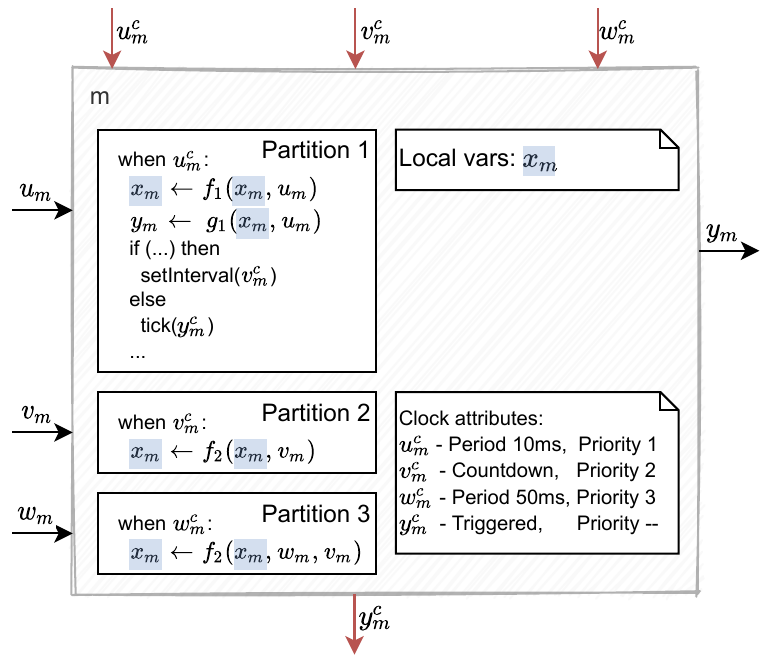
Figure 6. Motivating example, where an FMU declares three input clocks ( u c m , v c m , w c m ), one output clock ( y c m ) , three input ports ( u m , v m , w m ), and one output port ( y m